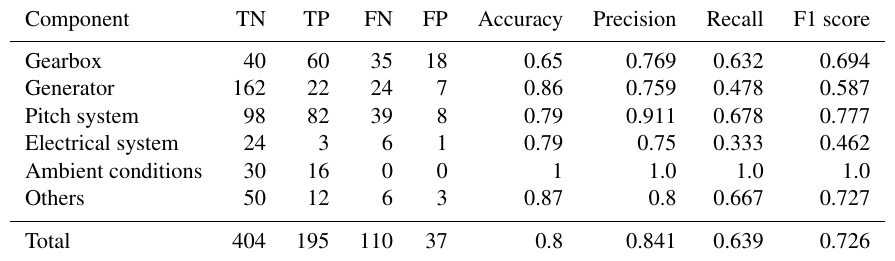
Table 2. Automated training data selection results per component for best configuration (Laplace/SD-max/ α cost = 150) on 2-year